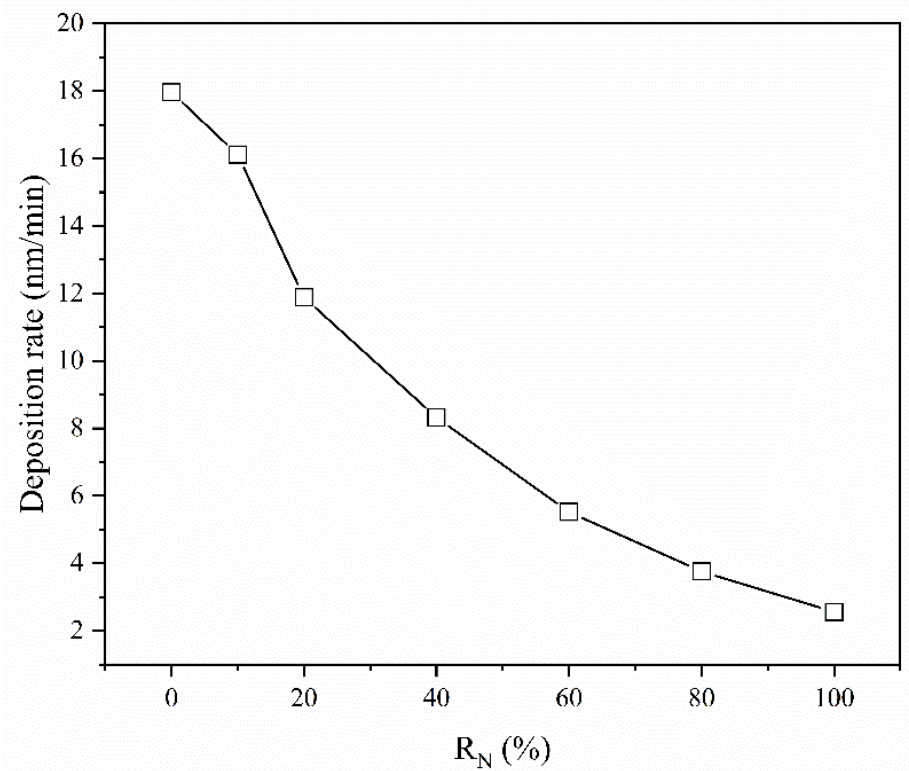
Figure 1. Deposition rate of (CrHfNbTaTiVZr)N coatings deposited at various R N